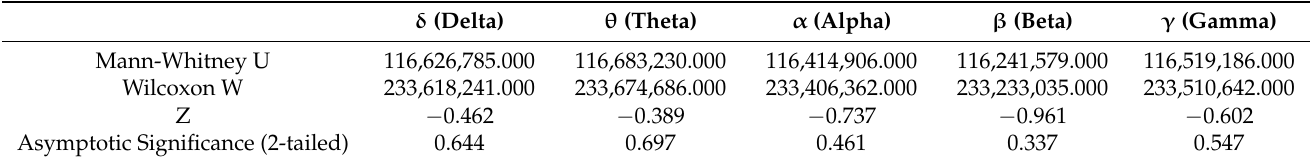
Table A8. Test Statistics for Mann-Whitney U Tests conducted on the Colour VDEP.